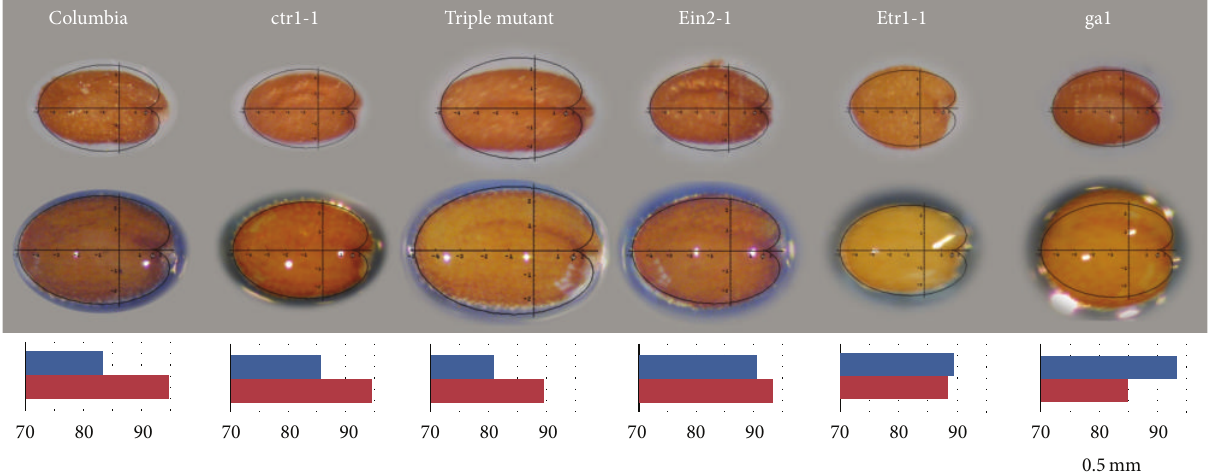
Figure 4: Dry seeds (top) and seeds imbibed during 1h (middle) of Columbia, ctr1-1 , etr1-1 , and ga1-1 mutants. Graphics show the values of 𝐽 index in dry seeds (above) and imbibed seeds (below). Triple mutant is ( ein2-1 , etr1-7 , and ers1-2 ) [10]. Scale bar represents 0.5